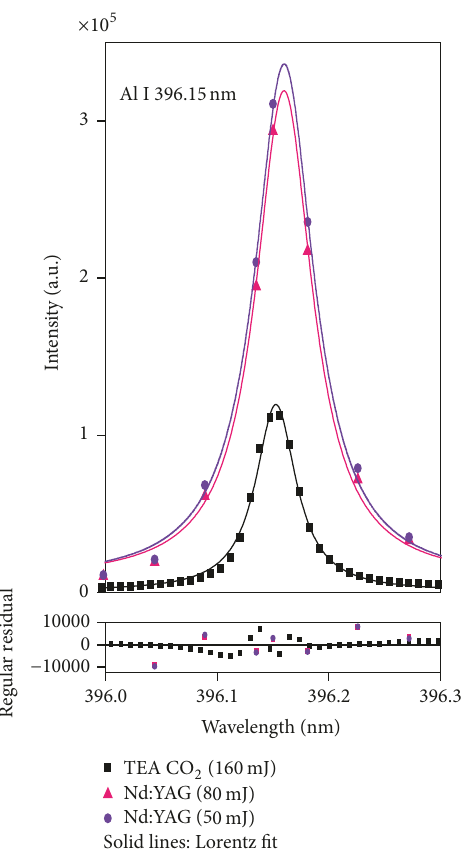
Figure 5: Al 396.15 nm line whose Stark width was used for evaluation of electron number density.